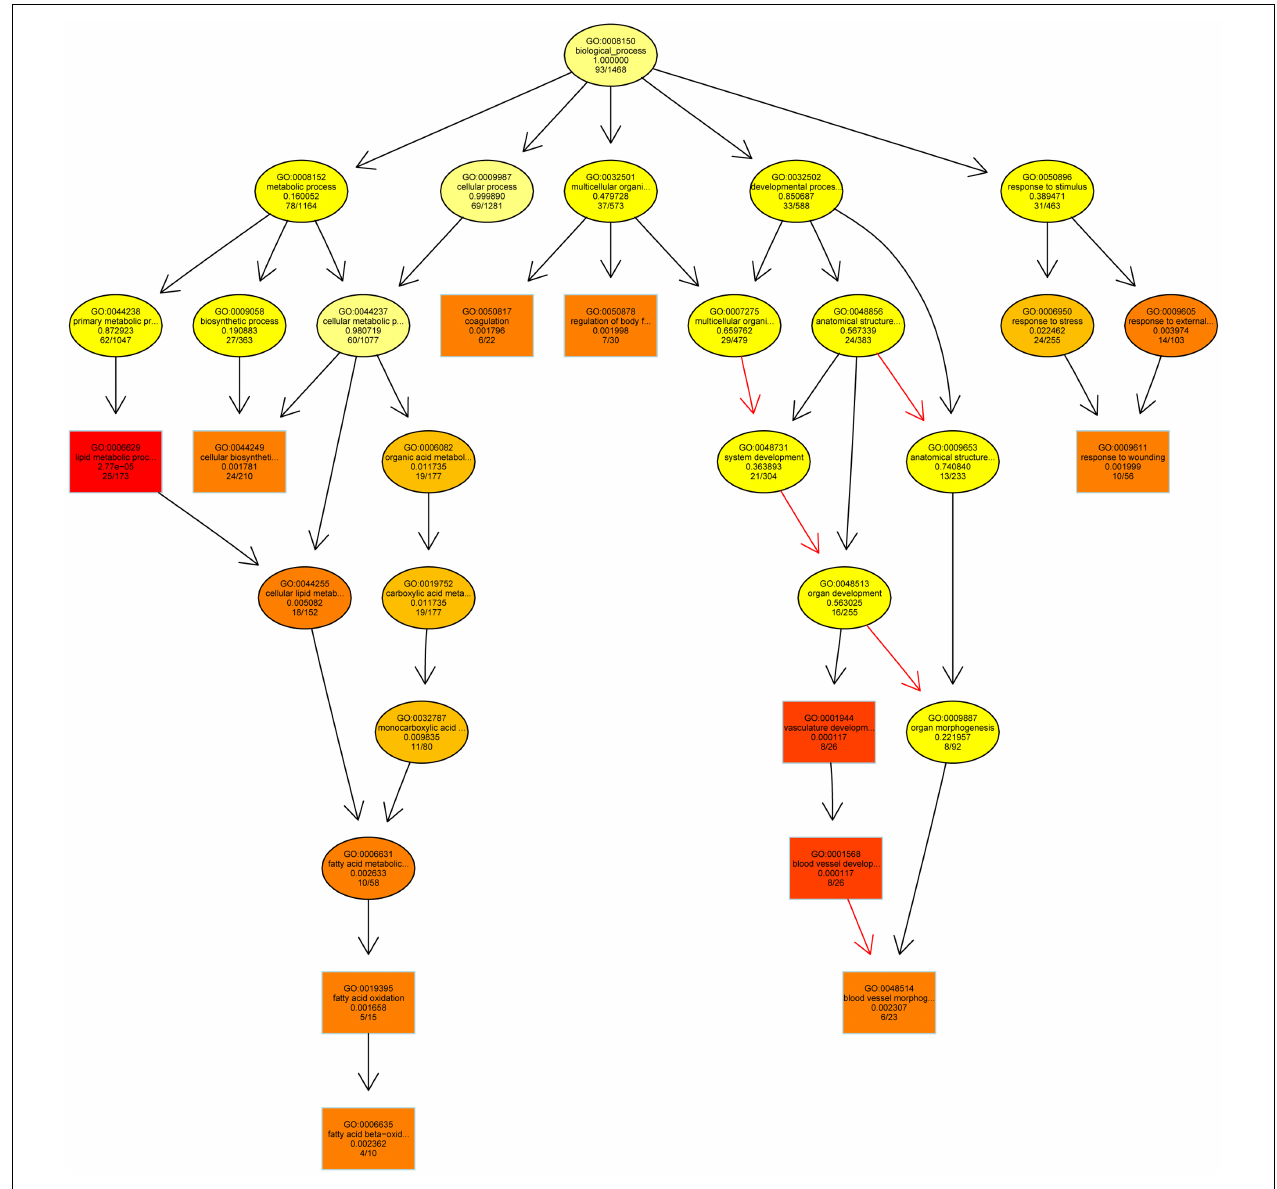
Increasing coloring toward red represents increasing significance levels. Each sphere contains GO ID, description, significance level, and ratio regulated: total genes in GO